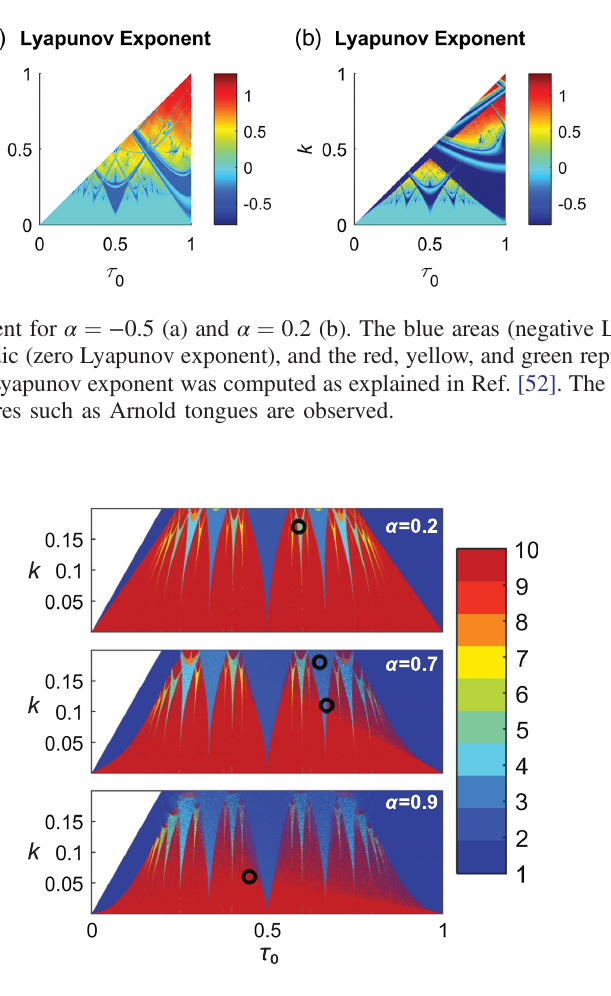
FIG. 6. Periodicity map showing the Arnold tongues in the absence of noise for the values of α extracted from the experimental data sets. For example, dark blue denotes a fixed point region, light blue denotes a period 2 region, and dark red denotes either periods higher than 10 or quasiperiodic and chaotic regions. The black circles indicate the values of k and τ corresponding to the fit to the data (Cyanobacteria 2, lymphocytes, and EMT6 fitted parameters, with α ¼ 0 . 2 , 0.7, and 0.9, respectively; see Table II). Note the similar features for the various α , also similar for negative α , as shown in Fig. 3(a).